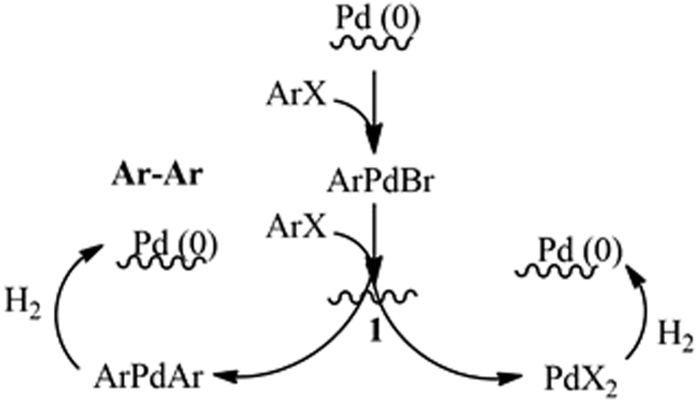
Proposed mechanism for the Pd-catalysed Ullmann reaction.